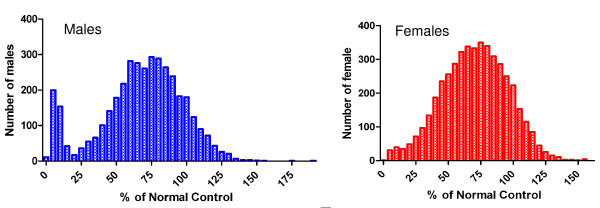
Distribution of G6PD activity in Isabel Island by gender. OD measures were converted to % activity relative to normal control and were graphed to visualise any difference in distribution pattern of G6PD activity between males and females.